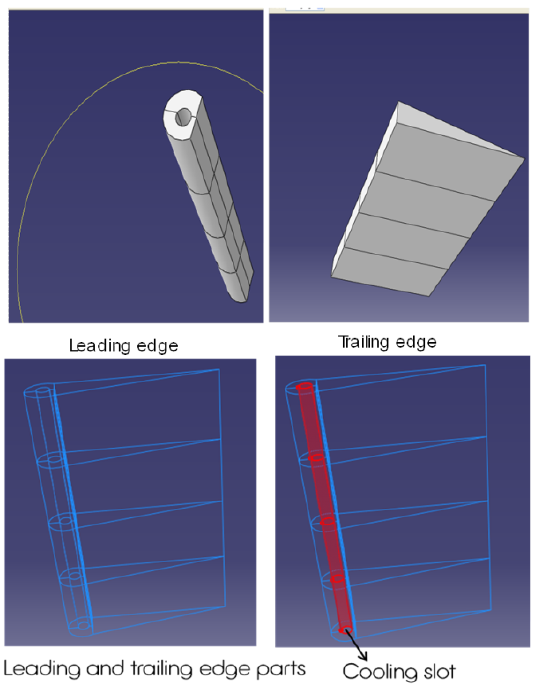
Figure 4: Outline blade geometry for FEA